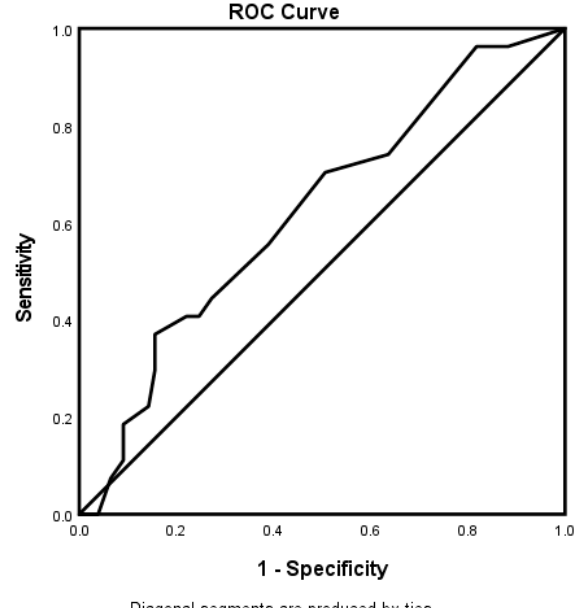
Figure 6. ROC curve associated with predicting stroke severity for patients ≥ 75 years old in the telestroke database. The area under the curve (AUC) values in the ROC analysis indicate discrimination of the score for the measured outcome. The classi fi cation table (overall correctly classi fi ed percentage = 76.3%) and the area under the ROC curve (AUC = 0.622, 0.502–0.743) were applied to check the model fi tness.